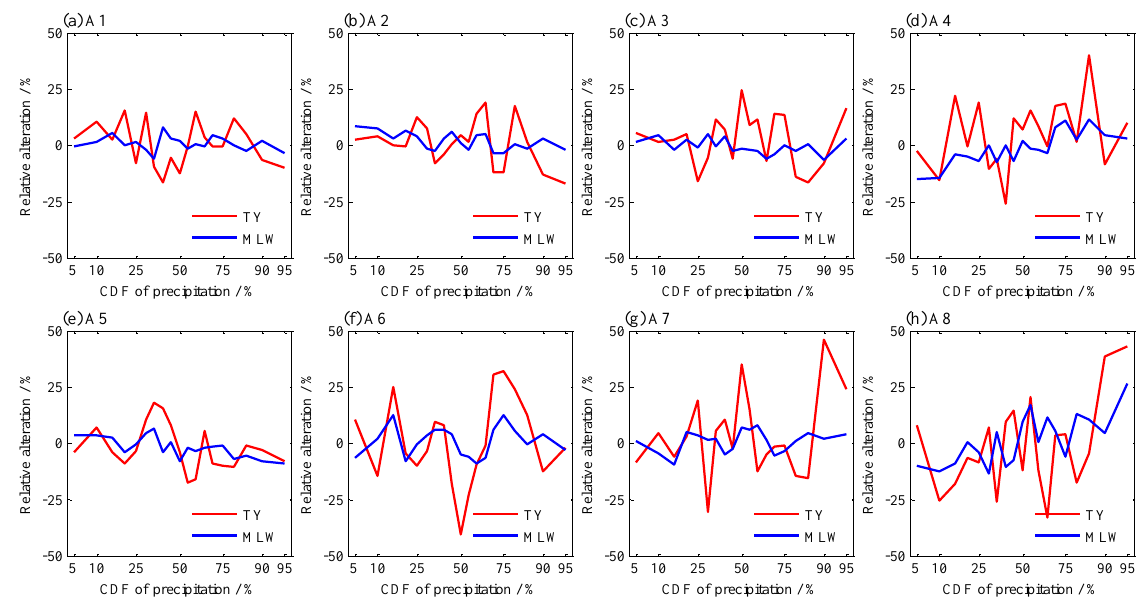
Figure 13. Relative alteration of design water demand compared to the EF method for given CDFs of precipitation of the entire region.